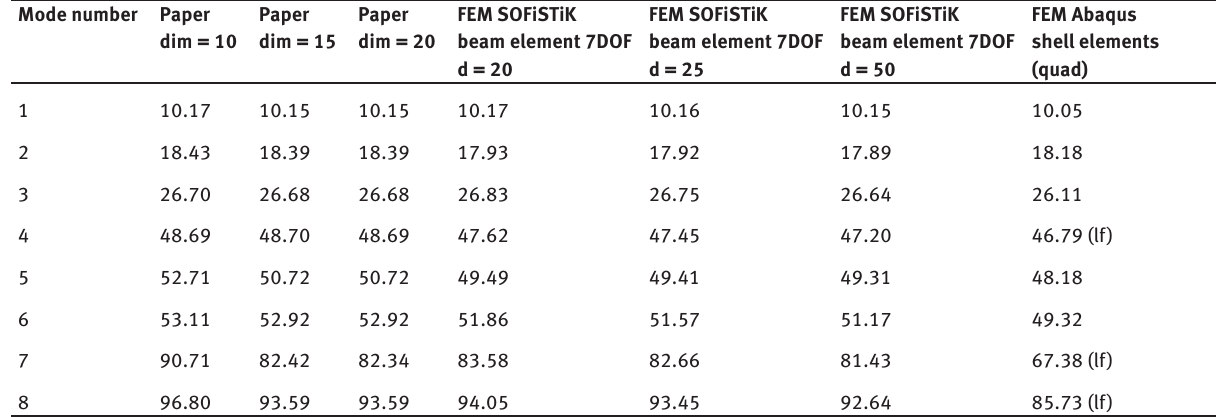
Table 1: Eigenfrequencies in case of clamped-clamped support (C-C)